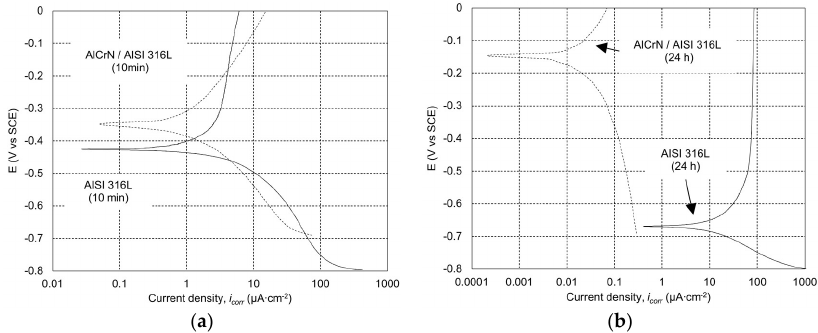
Figure 3. Potentiodynamic polarization curves (Tafel plots) of uncoated and AlCrN PVD coated AISI 316L specimens indicating corrosion potential: ( a ) after 10 min immersion; ( b ) after 24 h immersion. Table 3. Potentiodynamic polarization of uncoated and coated specimens.